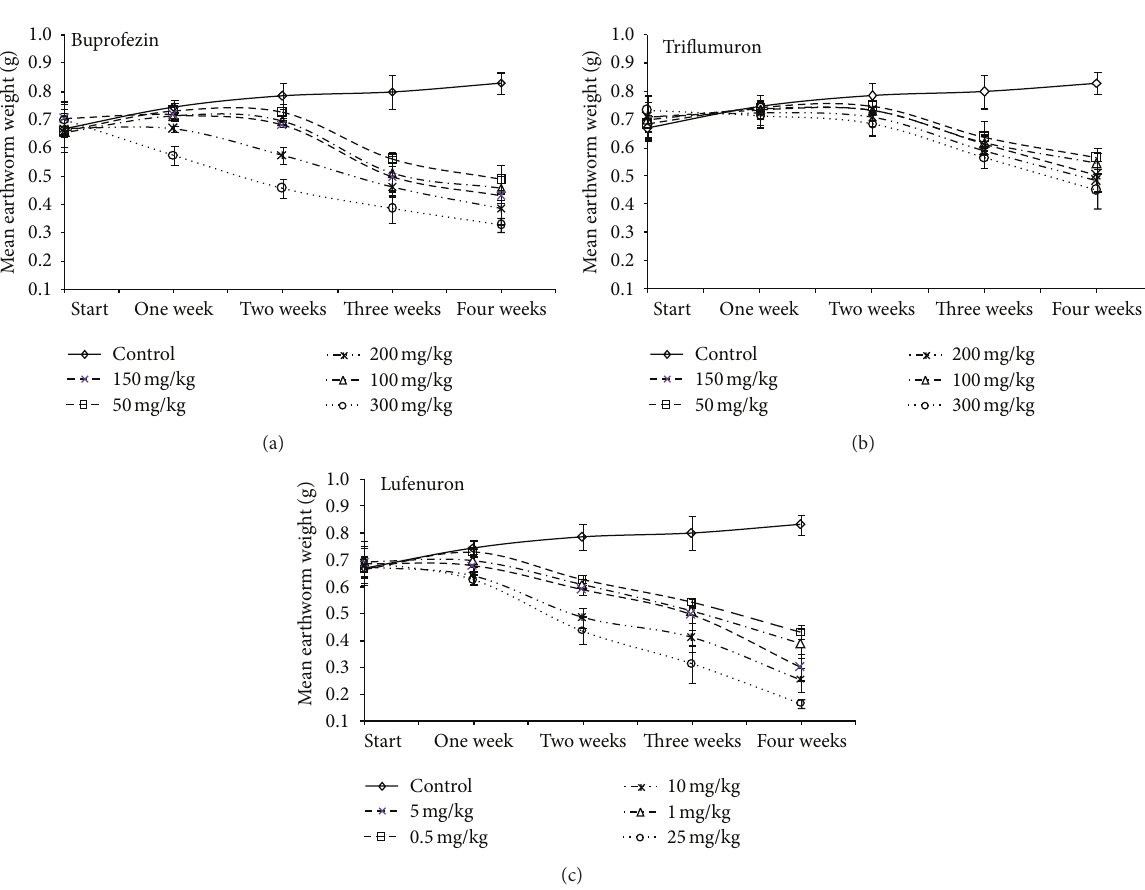
(CDNB) as substrate. The specific activity was expressed as OD 340 ⋅ min −1 ⋅ mg protein −1 . I 50 , the concentration producing 50% inhibition of enzyme activity was calculated according to probit analysis